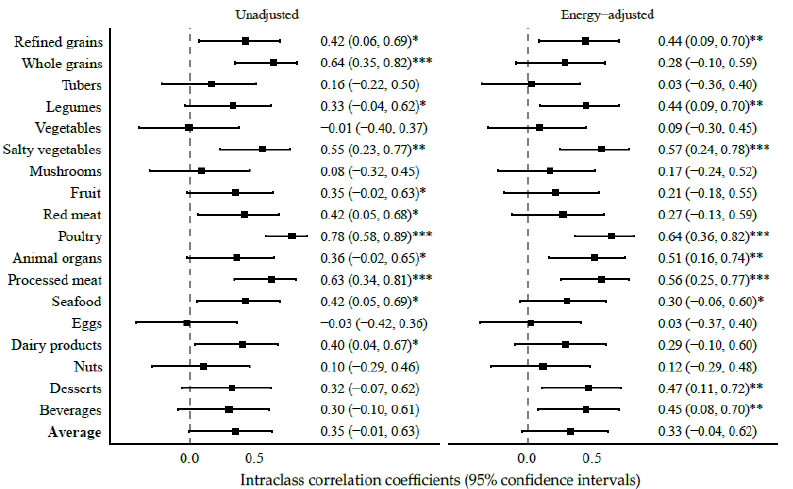
Figure 4. Intraclass correlation coefficients (ICCs) and 95% confidence intervals of food group in- takes estimated by the SFFQ in the International Human Phenome Project (phase I). * p < 0.05; ** p < 0.01; *** p < 0.001. *** p <